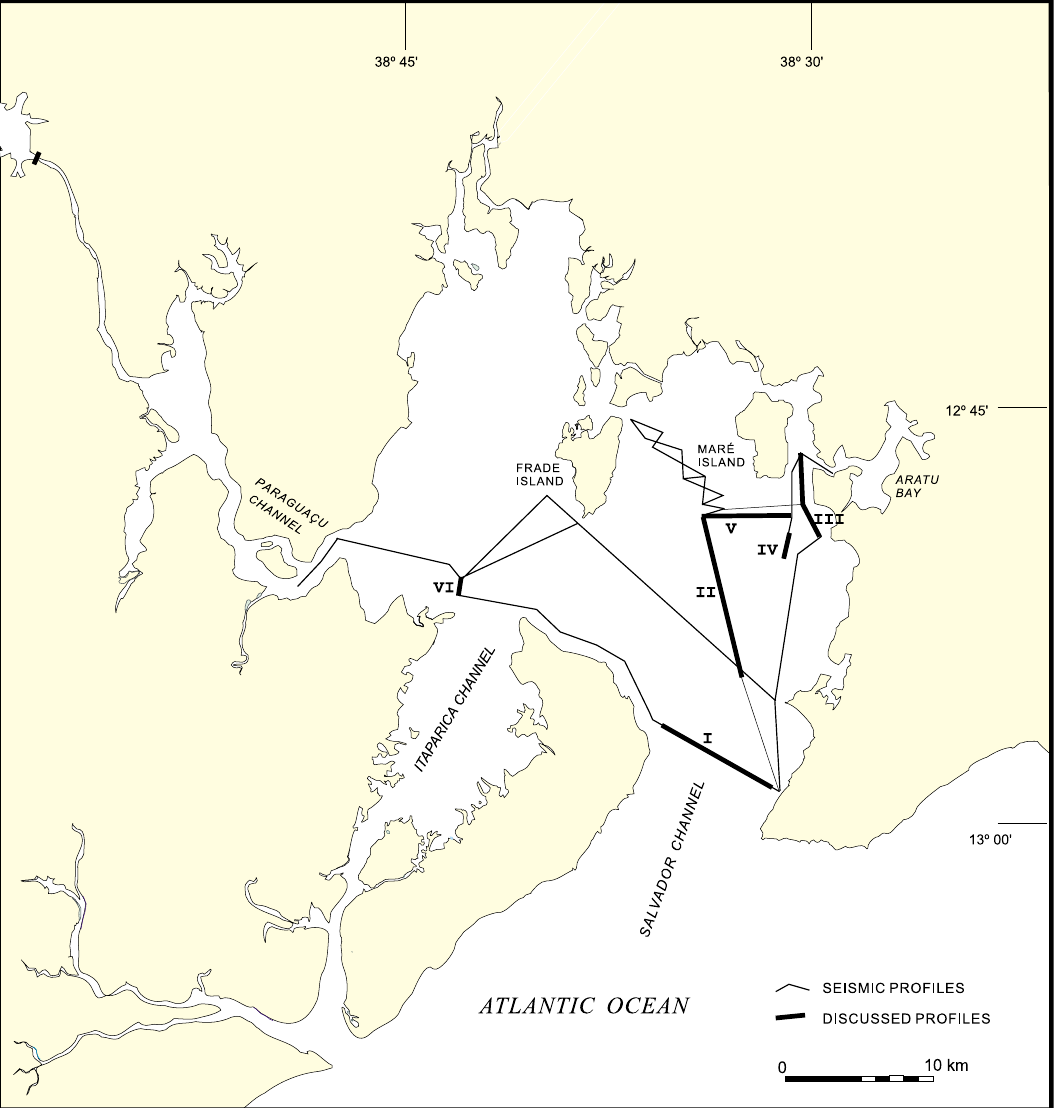
Fig. 4 – Location of the seismic profiling inside the TSB and profiles analyzed in this study.